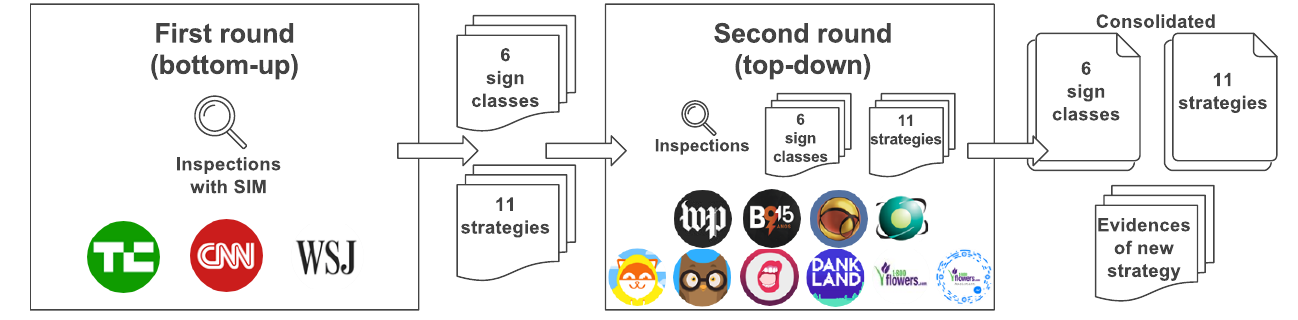
Fig. 1. Methodology